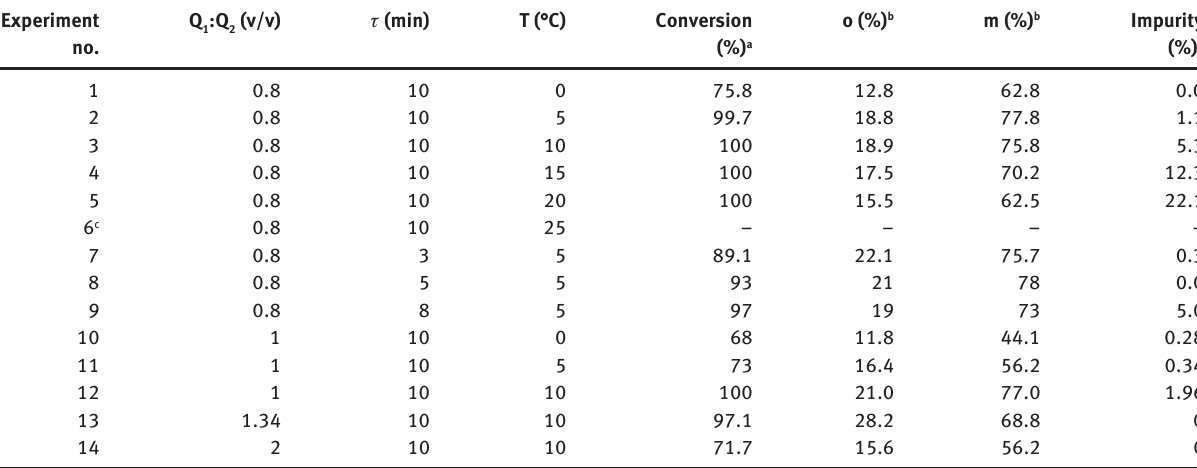
= AcPh+H ∼ 1:2.58 v/v at 25 ° C, Q SO 1 2 4